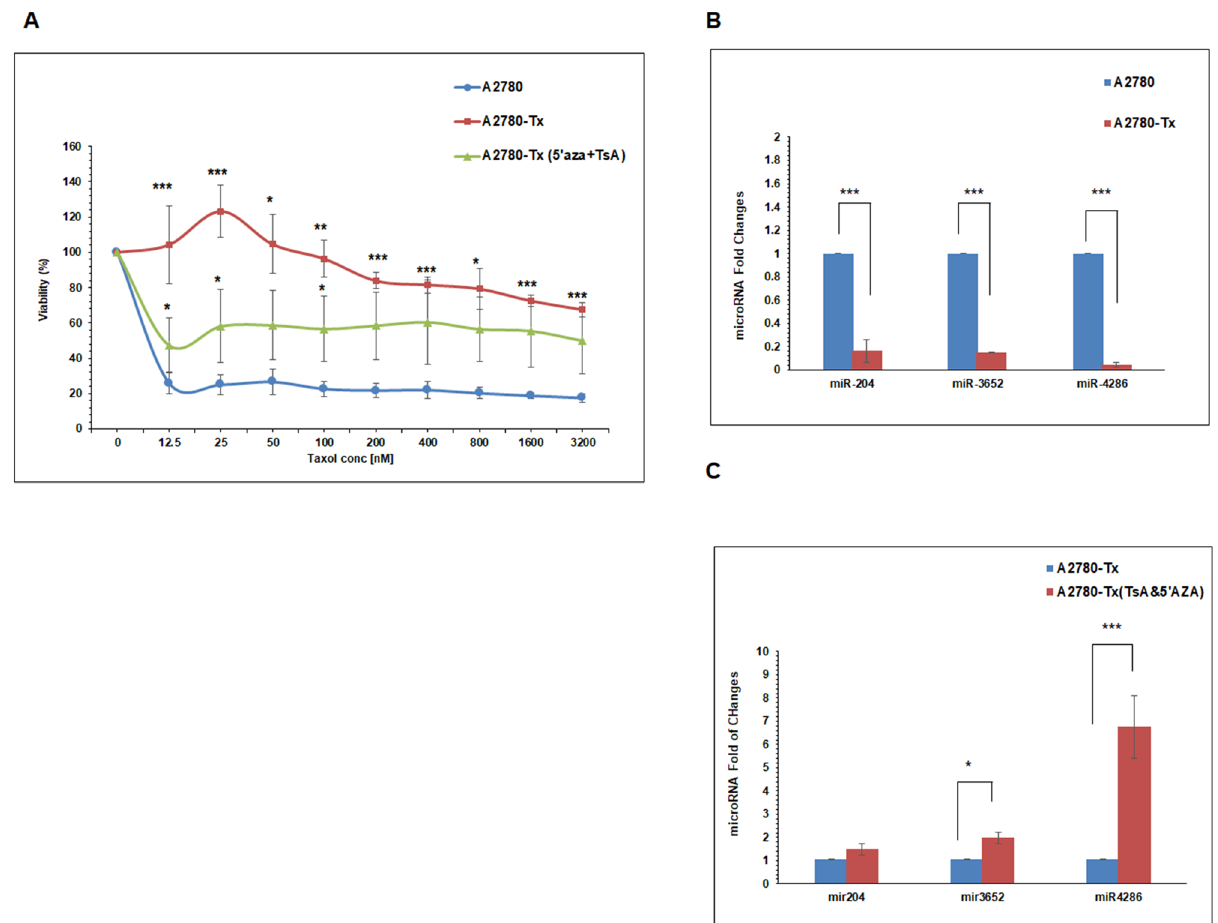
Figure 2. Differential expression of the selected miRNAs in A2780 and A2780-Tx cells. ( A ) Diffrential viability curve of the the taxol responsive A2780 cells versus taxol-resiatnt A2780-Tx cells and A2780 cells treated with epigenetic modulators (5 ′ AZA and TsA) beside the indicated concentrations of PTX. ( B ) QPCR analysis of the selected micorRNAs in A2780 versus A2780-Tx cells. ( C ) Relative expression of the same set of microRs in A2780-Tx cells before and after co-treatment with 5 ′ AZA (10 µM; three days) and TsA (300 nM; one day). U6 was used as a control. One way anlysis of variance (ANOVA) was performed to get the satsitical significance of diffrence at each point (* p < 0.05, ** p < 0.01 and *** p < 0.001).